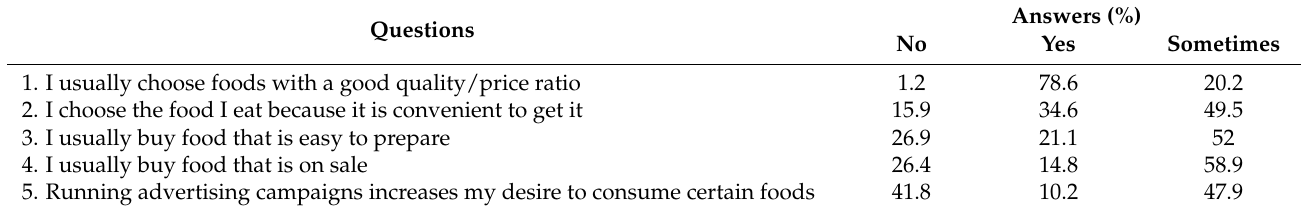
Table 2. Participants’ motivations for food